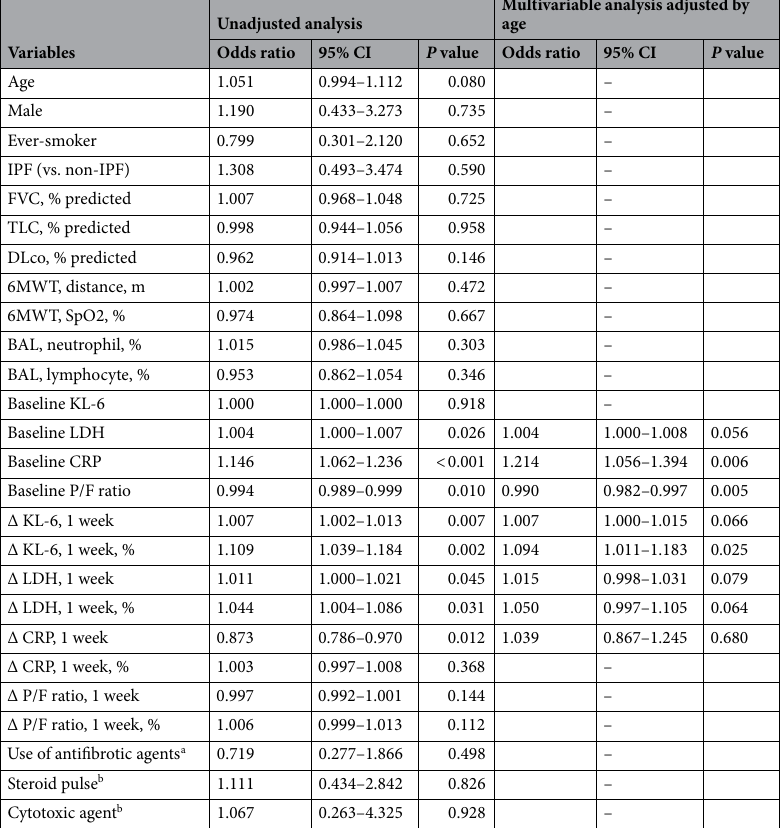
Table 4. Logistic regression analysis for in-hospital mortality in patients with AE-ILD. a At the time of hospitalization; b treatment for AE during hospitalization. AE-ILD acute exacerbation of interstitial lung disease, IPF idiopathic pulmonary fibrosis, FVC forced vital capacity, TLC total lung capacity, DLco diffusing capacity of the lung for carbon monoxide, 6MWT 6-min walk test, BAL bronchoalveolar lavage, KL-6 Krebs von den Lungen-6, LDH lactate dehydrogenase, CRP C-reactive protein, P/F ratio ratio of partial pressure of oxygen to the fraction of inspiratory oxygen, Δ changes from